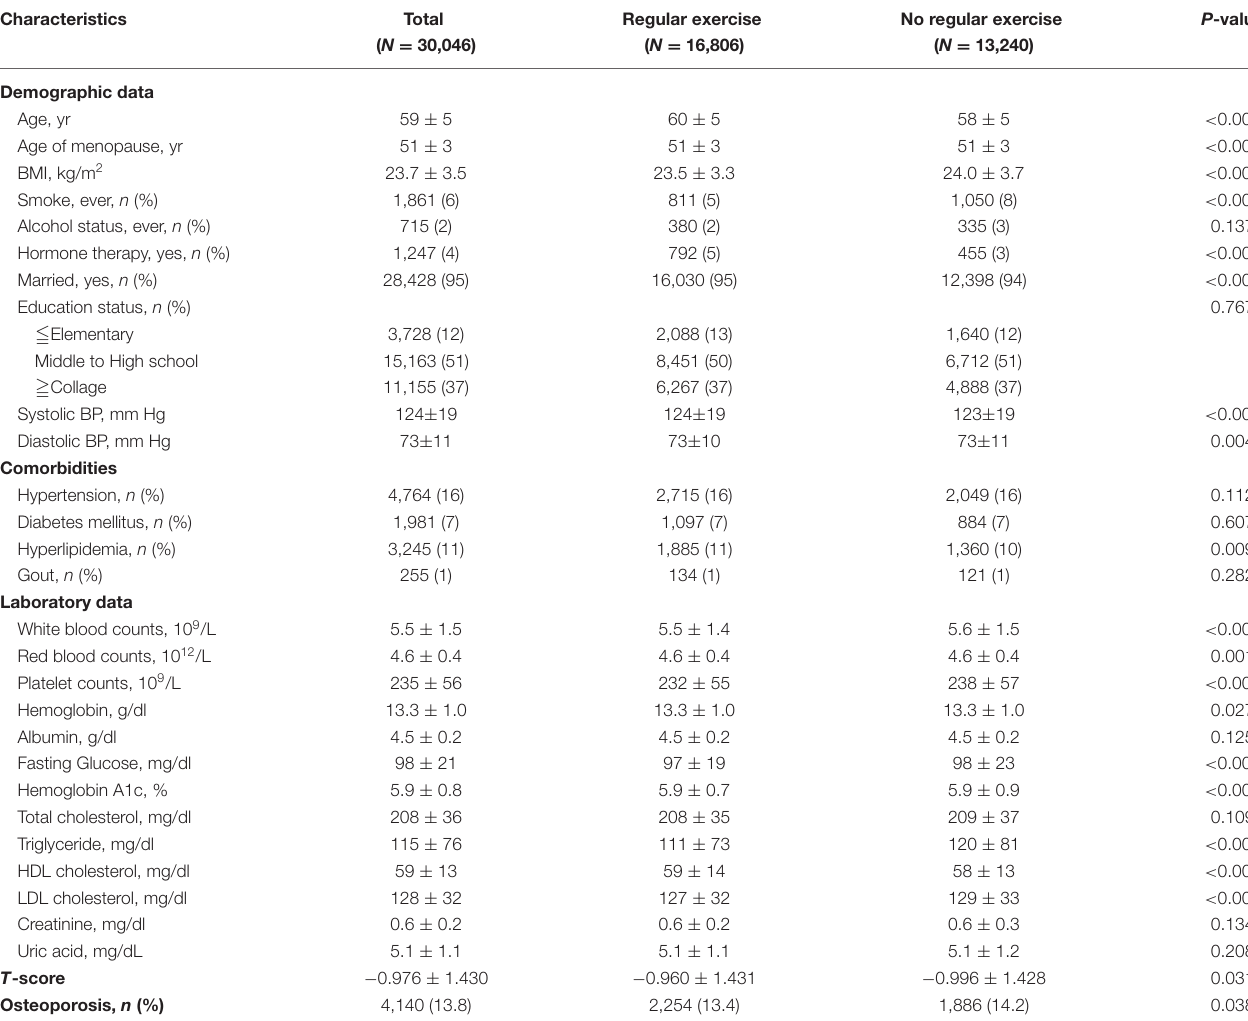
TABLE 1 | General characteristics of postmenopausal women in the cross-sectional cohort ( N = 30,046).